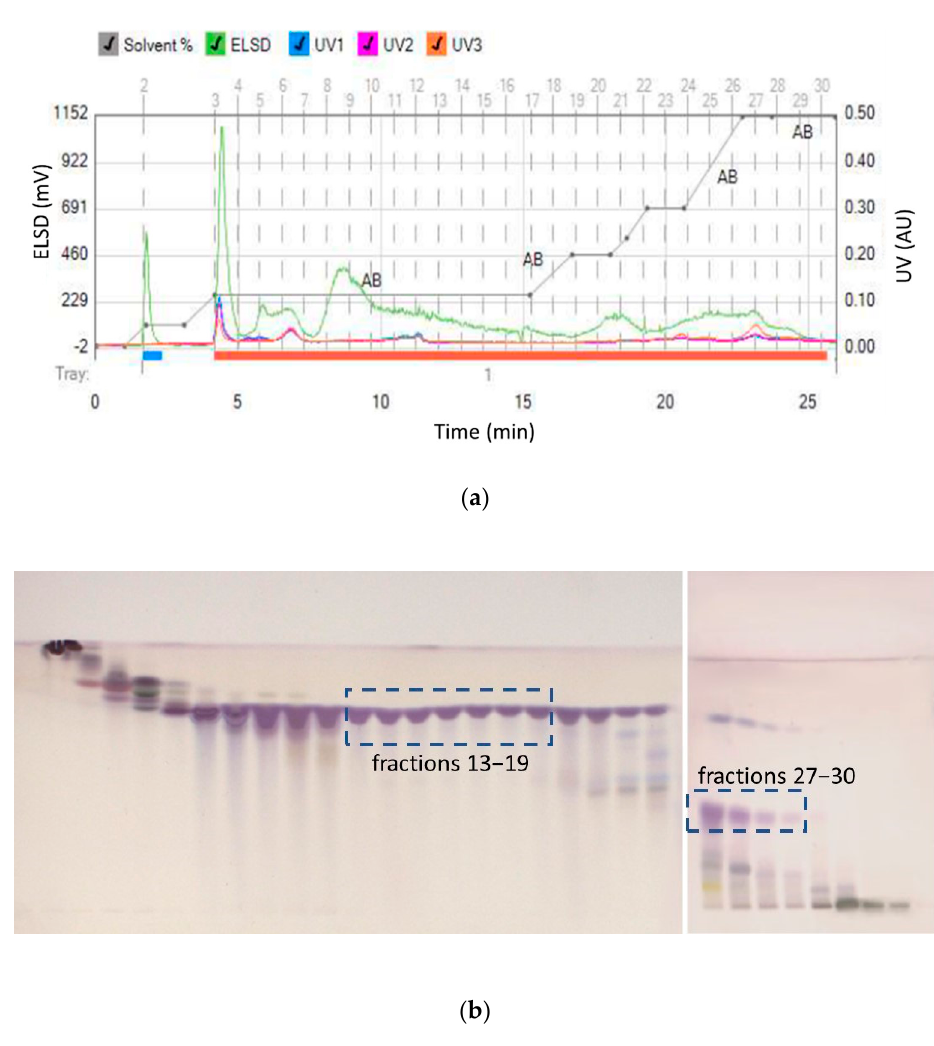
Figure 3. ( a ) Separation of ethyl acetate extract and ( b ) HPTLC assessment of collected fractions (13– 19 high purity oleanolic acid and 27–30 low purity maslinic